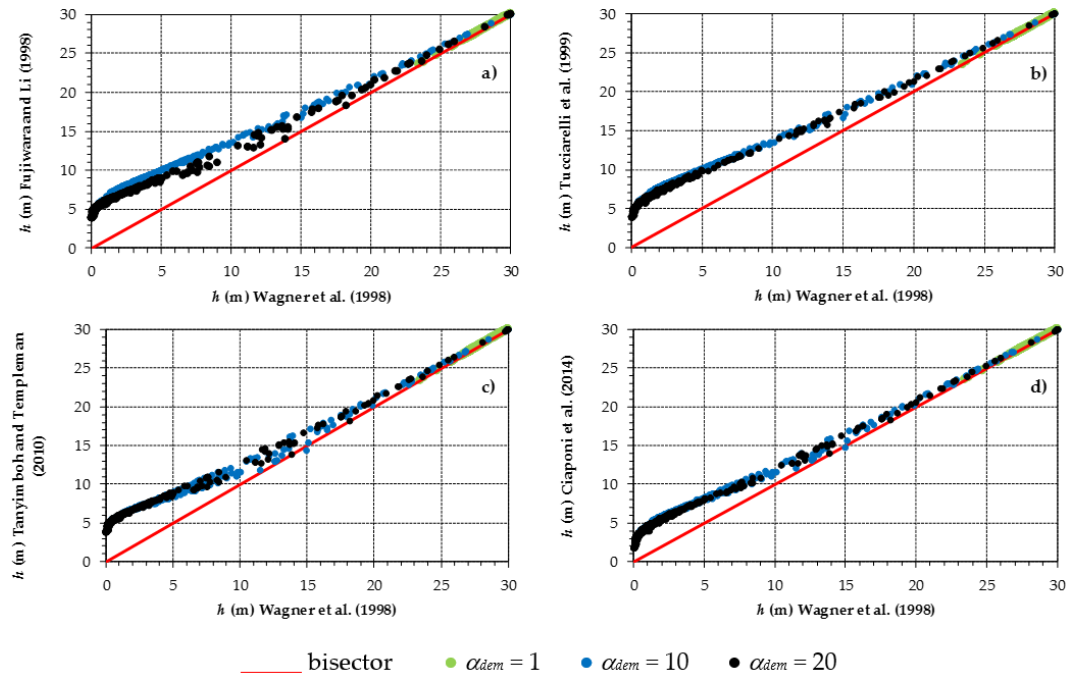
Figure 11. Second case study. Comparison of the various formulations, ( a ) Fujiwara and Li [12], ( b ) Tucciarelli et al. [13], ( c ) Tanyimboh and Templeman [17] and ( d ) Ciaponi et al. [20], in terms of nodal pressure head h .